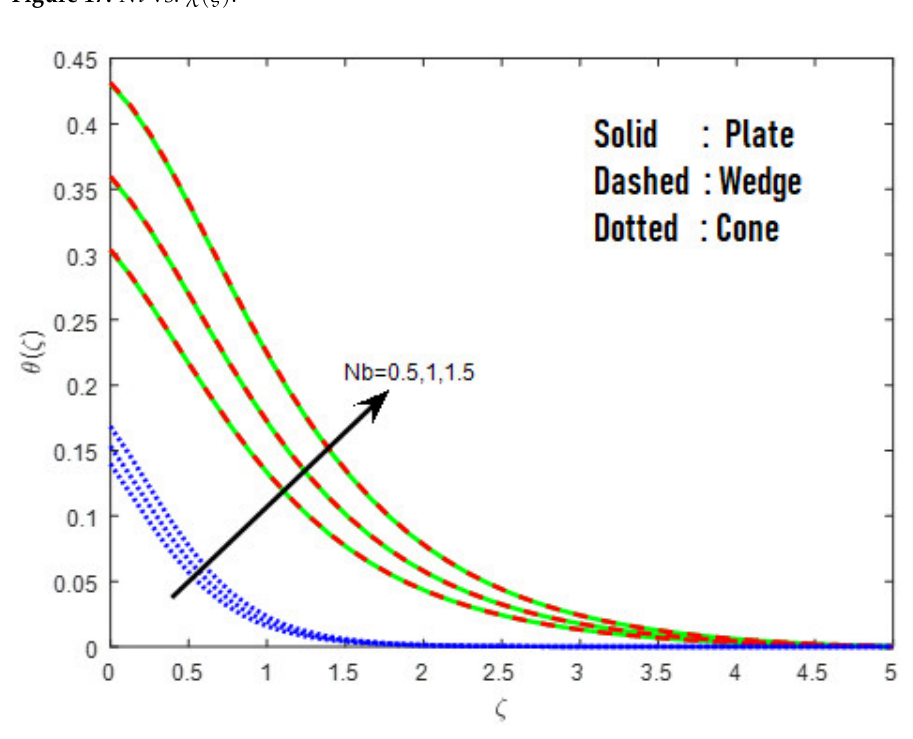
    . Figure 18. Nb vs. θ ( ζ )     .